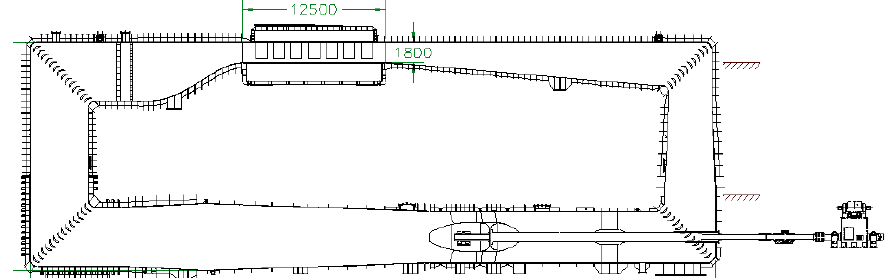
Figure 3. Schematic view of the Large Cavitation Tunnel (LCT) at the Korea Research Institute of Ships and Ocean Engineering